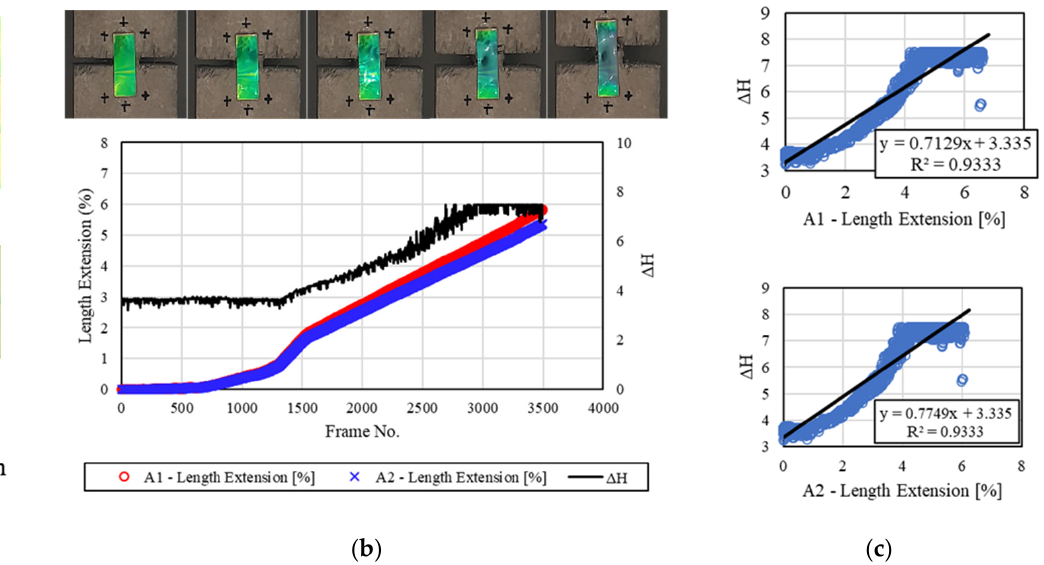
Figure 5. Results for the non-F–T specimen. ( a ) H-value image for discoloration of mechanochromic sensor (90 ◦ rotation relative to tensile direction); ( b ) variations in strain and dH of A1 and A2 according to image frame. (The discoloration process of the mechanochromic sensor attached to the specimen and the tensile strain described in Figure 3 are shown.); ( c ) correlations of dH with A1 and A2.